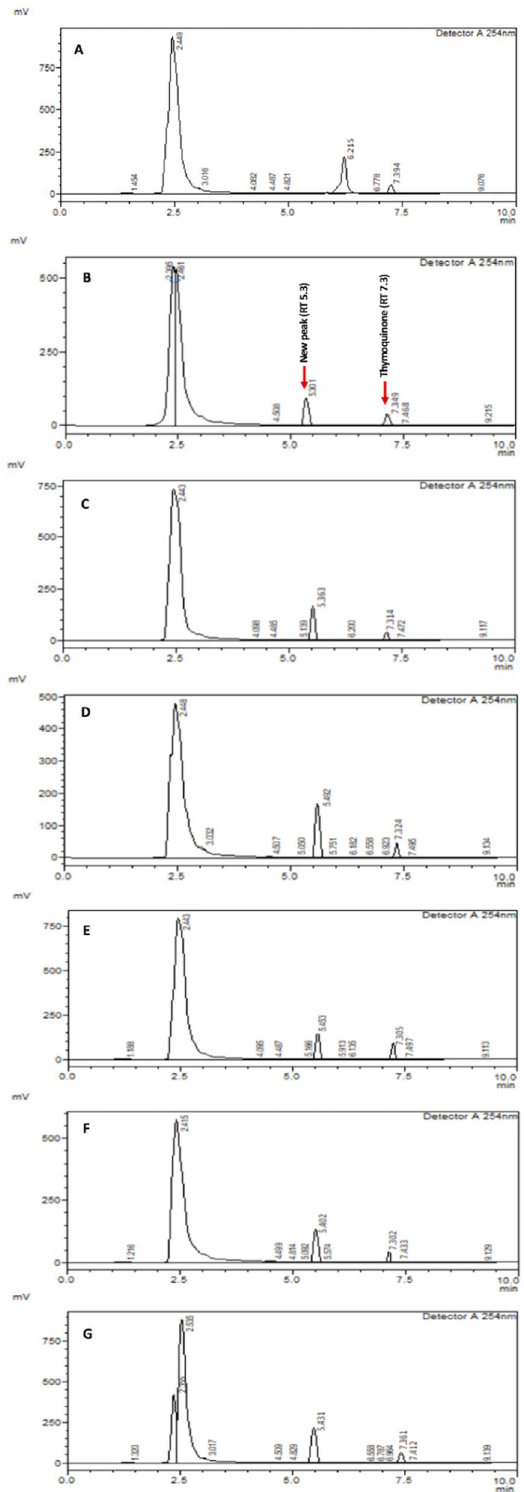
Figure 7. RP-HPLC histograms depict sodium azide dose-dependent new peak with retention time of 5.3 min along with thymoquinone peak (RT 7.3 min). ( A ) Control (0 µM sodium azide), ( B ) 5 µM sodium azide, ( C